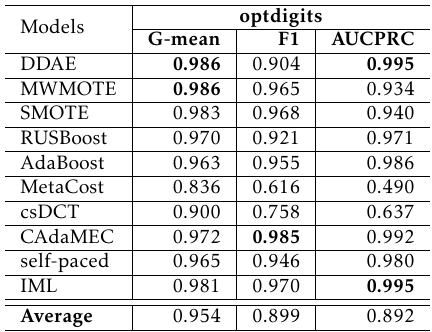
Table 11. Overall Results for optdigits Dataset Models